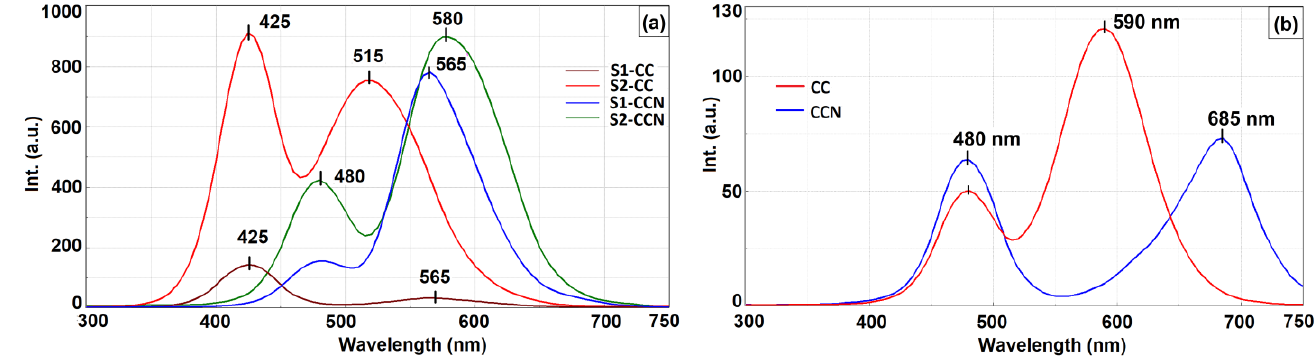
Figure 10. Fluorescence emission spectra of colored nanocomposites ( a ) and curcumin derivative ( b ).